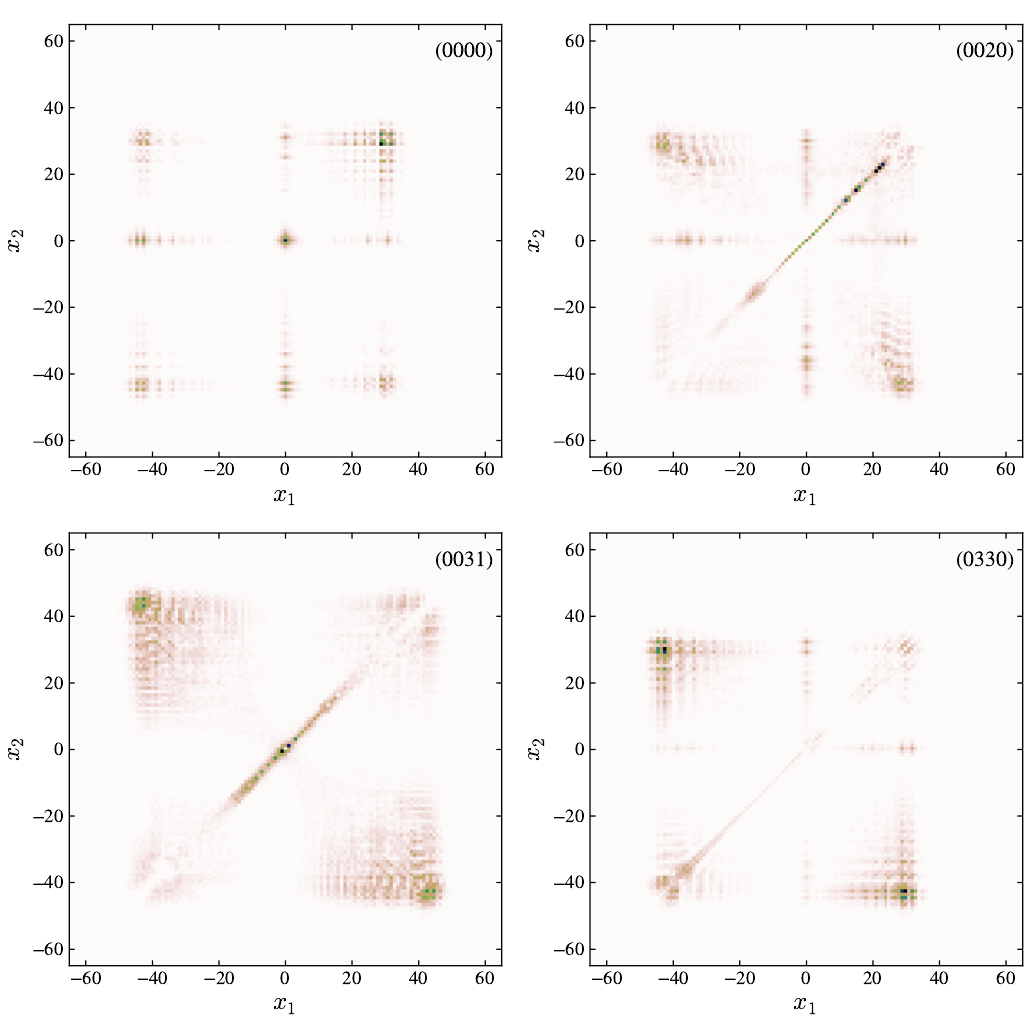
Figure 5: Two particle probability distribution (after 60 steps), with initial state Bell ‘0’ and left charge ‘0’ and right charge ‘1’. In the non-interacting case there is a localized state at the origin (left, code ( 0000 ) ); in the presence of interaction, φ = π/ 2, a binding state of the two particle becomes itinerant (right, code ( 0020 ) ); for a weak interaction strength the localized state persists. In the trivial interacting system, a localized state appears ( 0031 ) , for φ = 3 π/ 4 ) , while for the antisymmetric state ( 0330 ) is delocalized, in spite of the